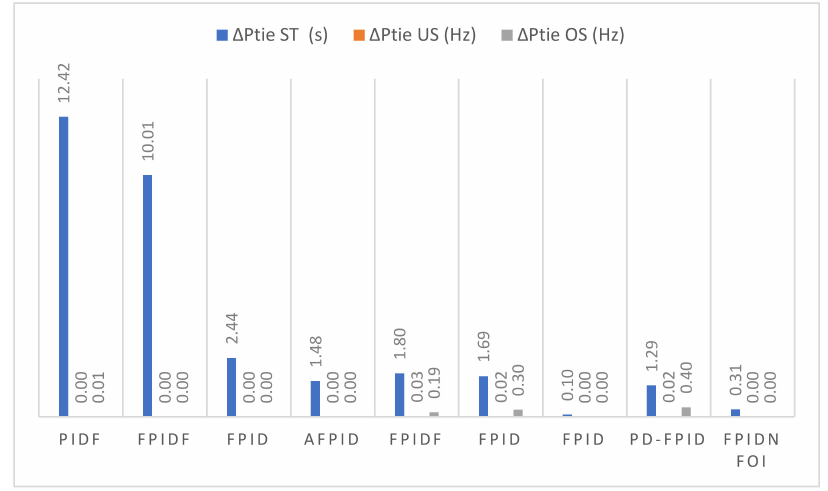
Figure 10. Frequency Deviation for Interconnected Systems.